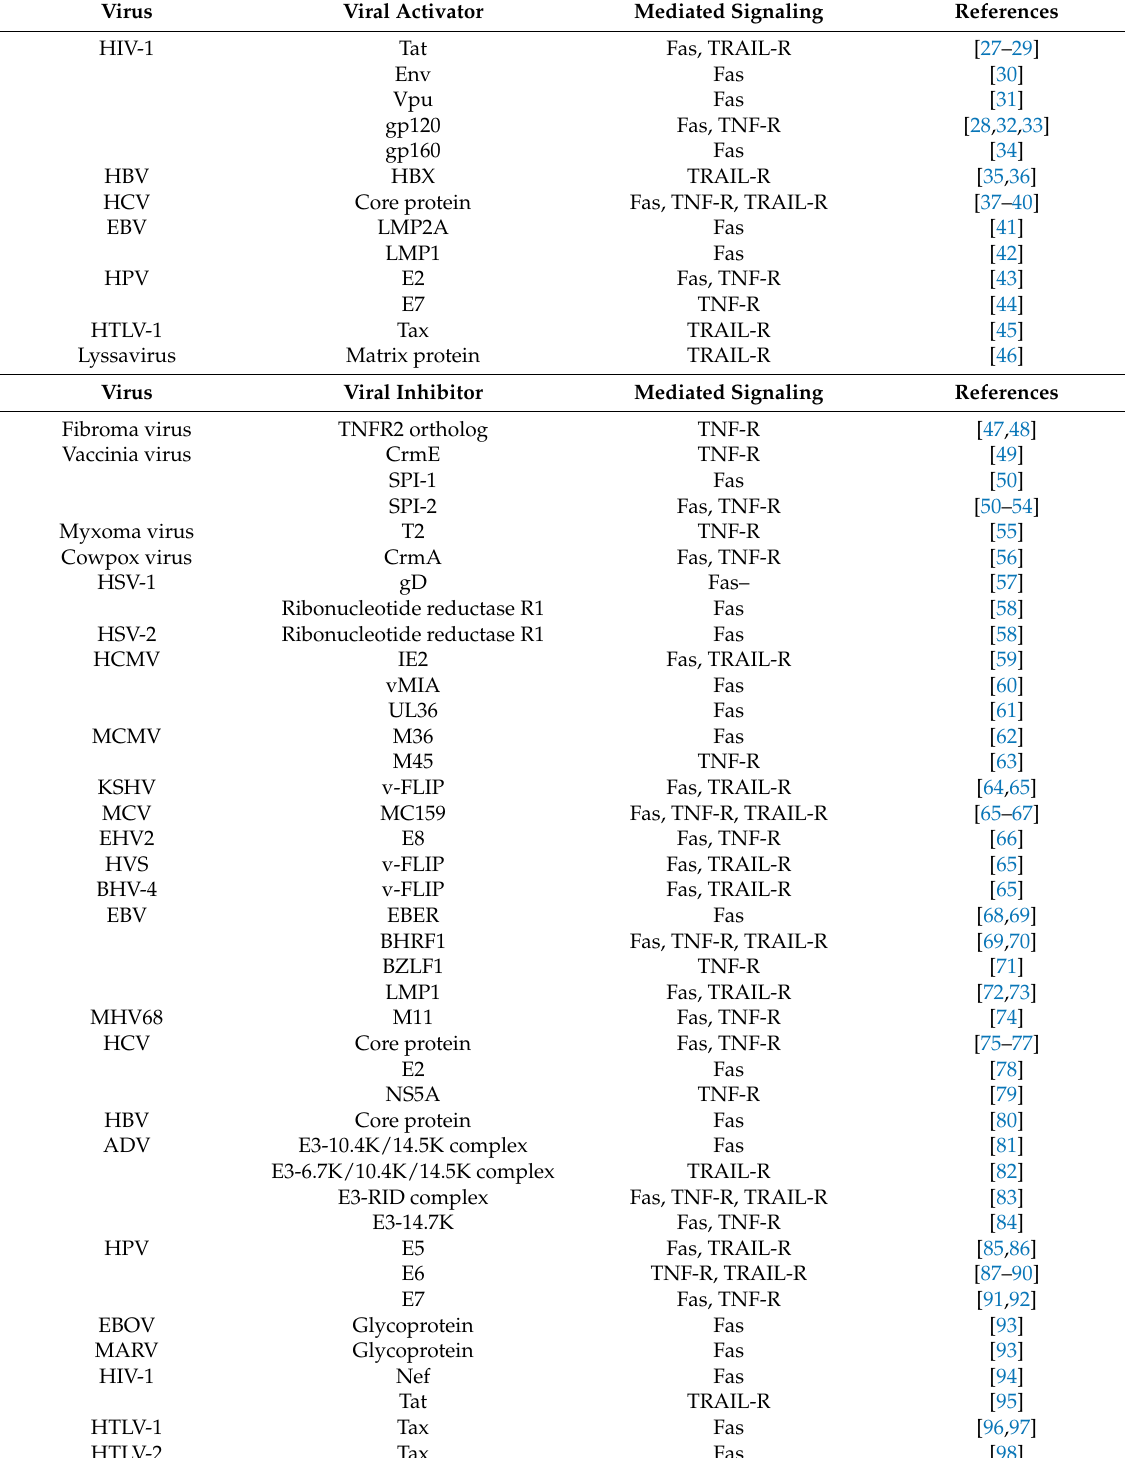
Table 1. Viral proteins that modulate death receptor-mediated